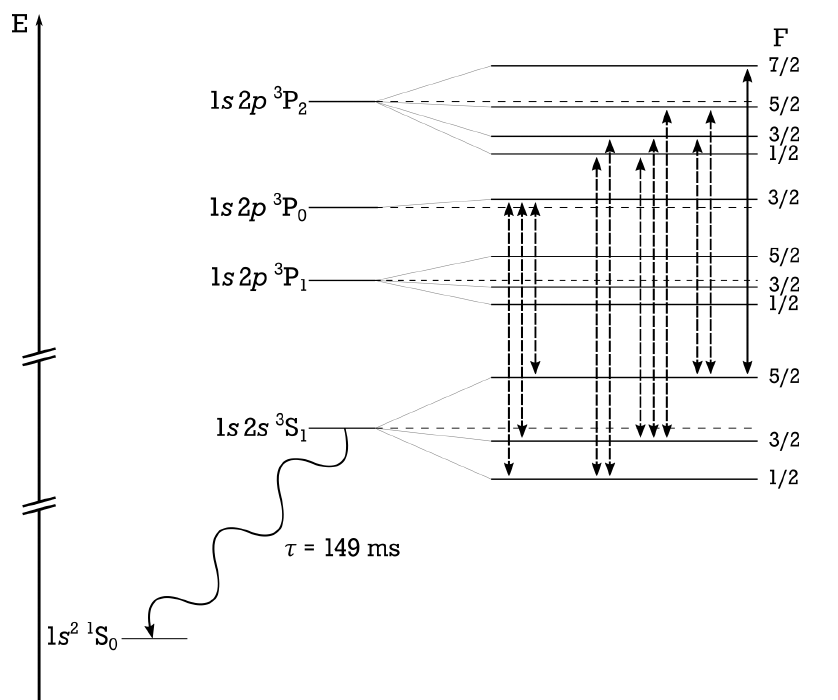
Figure 3. Level scheme of 11 B 3+ . All transitions, which were measured during the measurement campaign, are indicated by straight arrows: The strongest hyperfine transition that was used as reference line is the solid line, while all others are indicated by the dashed lines. The M1-transition from the metastable 2 s 2 p 3 S 1 to the ground state 1 s 2 1 S 0 is depicted with its lifetime τ = 149ms taken from